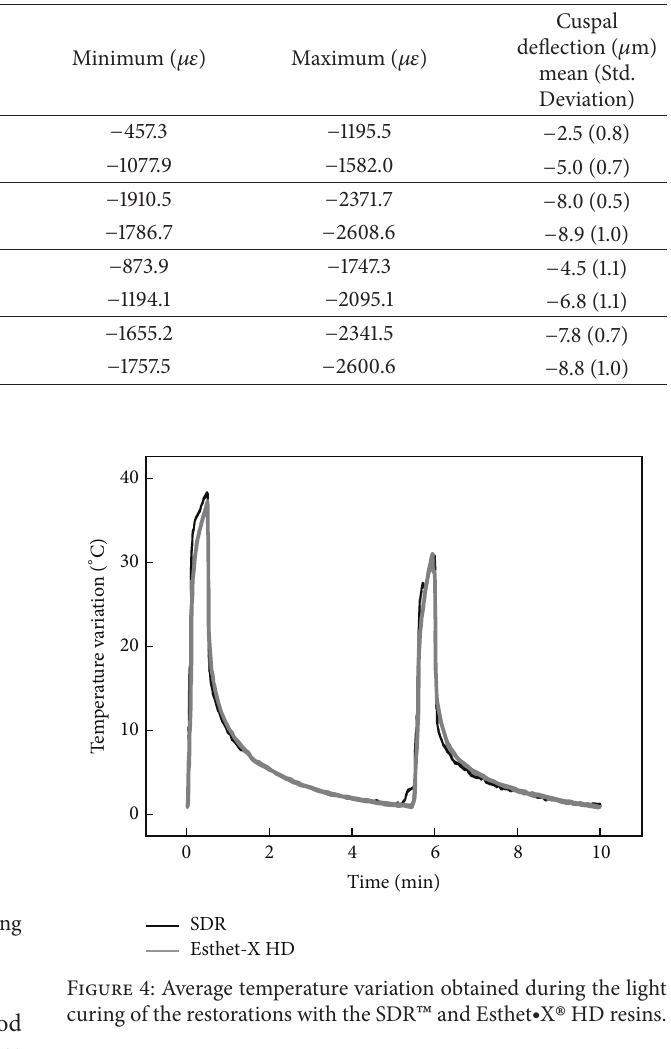
− 1299.5 𝜇𝜀 and − 646.3 𝜇𝜀 for Esthet ∙ X (cid:2) HD and SDR (cid:3) , respectively (Figure 5 and Table 2). ANCOVA analysis con- sidering temperature as the covariate revealed a statistically significant difference in cuspal deflection between the two resin composite resins at 30 seconds of polymerization ( 𝐹(1, 17) = 52.69 , 𝑝 < 0.01 , partial 𝜂 2 = 0.756 ). 𝑡 -test for independent samples equality of means revealed deformation values statistically significantly higher in Esthet ∙ X (cid:2) HD compared to SDR (cid:3) (Table